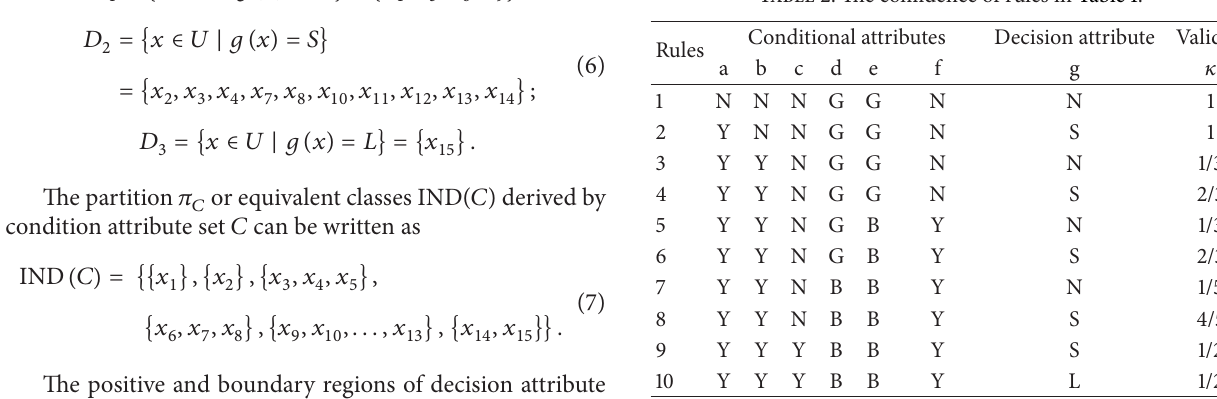
Table 2: The confidence of rules in Table